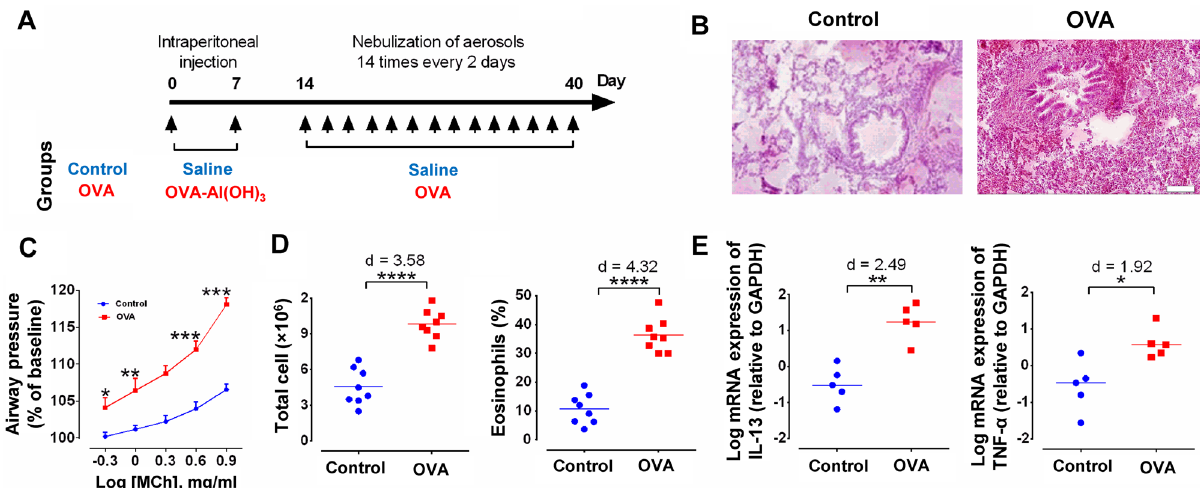
Figure 1. Study design and inflammatory responses in the lung. ( A ) Timeline of the study design. The rats received 2 intraperitoneal injections of saline or OVA-Al(OH) 3 on day 0 and day 7, and 14 inhalation exposures (for 30 min, every 2 days, from day 14 to day 40) with aerosols of saline or OVA solution (2% wt/vol). ( B ) Lung H&E staining to recognize peribronchovascular inflammatory cell infiltration. Scale bar represents 50 μm. ( C ) Airway hyperresponsiveness following increasing doses of methacholine. Data are presented as percent of baseline, expressed as mean ± SEM, and analyzed by two-way repeated measures ANOVA, with the Bonferroni post-hoc test, n = 8 per group. ( D ) Total inflammatory cells (left panel) and eosinophils (right panel) in BALF. The horizontal bars represent mean values. Data were analyzed by t-test, n = 8 per group. ( E ) mRNA expression of IL-13 (left panel) and TNF-α (right panel) in the lung. The horizontal bars represent median values. Data were analyzed by Mann–Whitney test, n = 5 per group. *p < 0.05, **p < 0.01,***p < 0.001 and ****p <